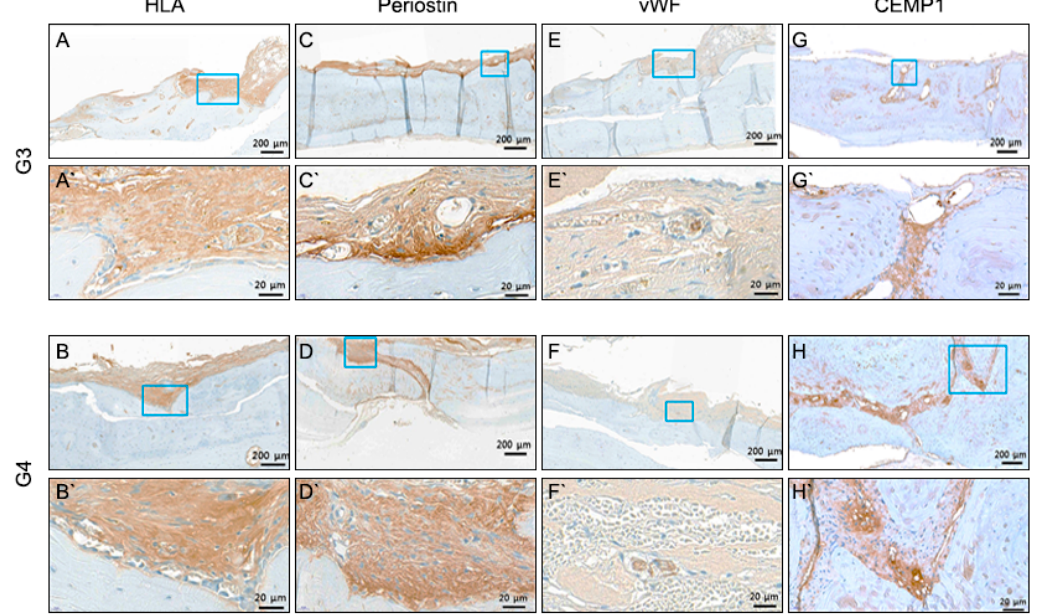
Figure 6. Immunohistochemistry of bioprinting group. ( A , B ) HLA specific staining; ( C , D ) Periostatin specific staining; ( E , F ) vWF specific staining; ( G , H ) CEMP1 specific protein. All four markers show the presence of connective tissue, which is evidence of periodontal ligament regeneration.